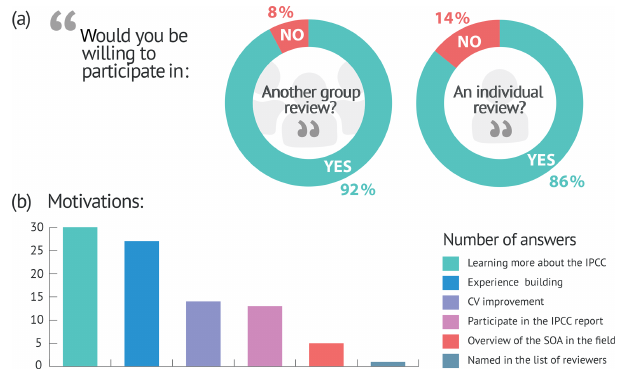
Figure 2. (a) Participants’ answers to the questions: “Would you be willing to participate in another group (left pie chart) and/or individ- ual (right pie chart) review?” and (b) motivations for participating in such a